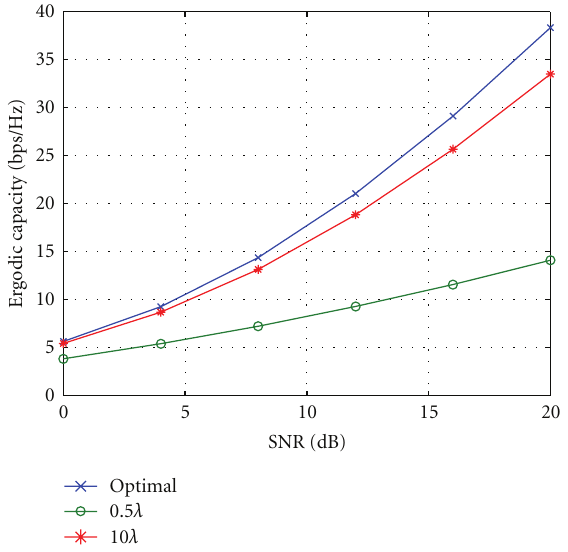
Figure 5: Ergodic capacity as a function of the displacement from the optimum point.